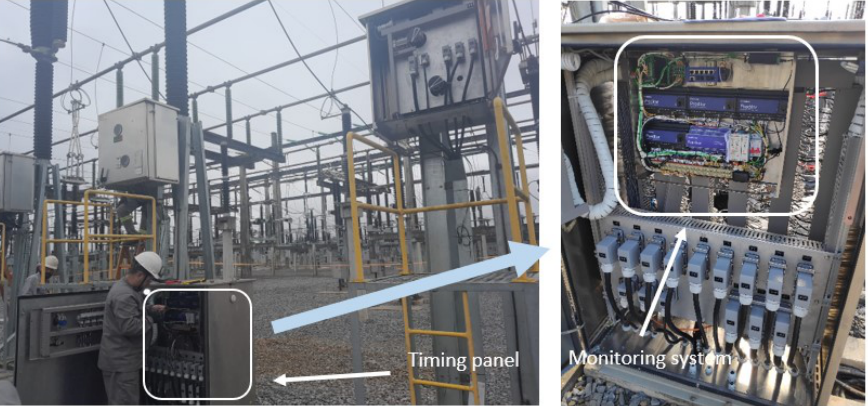
Figure 21. Case of the monitoring system installed in the HVCB synchronism